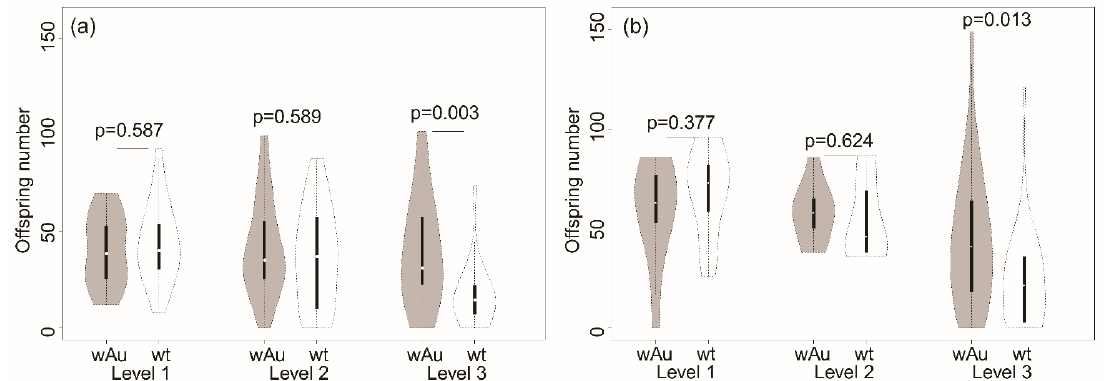
Figure 1. Violin plots for distribution of offspring number of w Au-infected and uninfected (wt) lines at different levels of fungal growth. ( a ) Offspring number of 9-day-old parents; ( b ) offspring number of 13-day-old parents. Levels 1 to 3 indicate the levels of fungus infestation on grapes as described in the text. Medians are indicated by central points, and the interquartile range by the solid bar, while the dotted line indicates the 95% confidence interval.